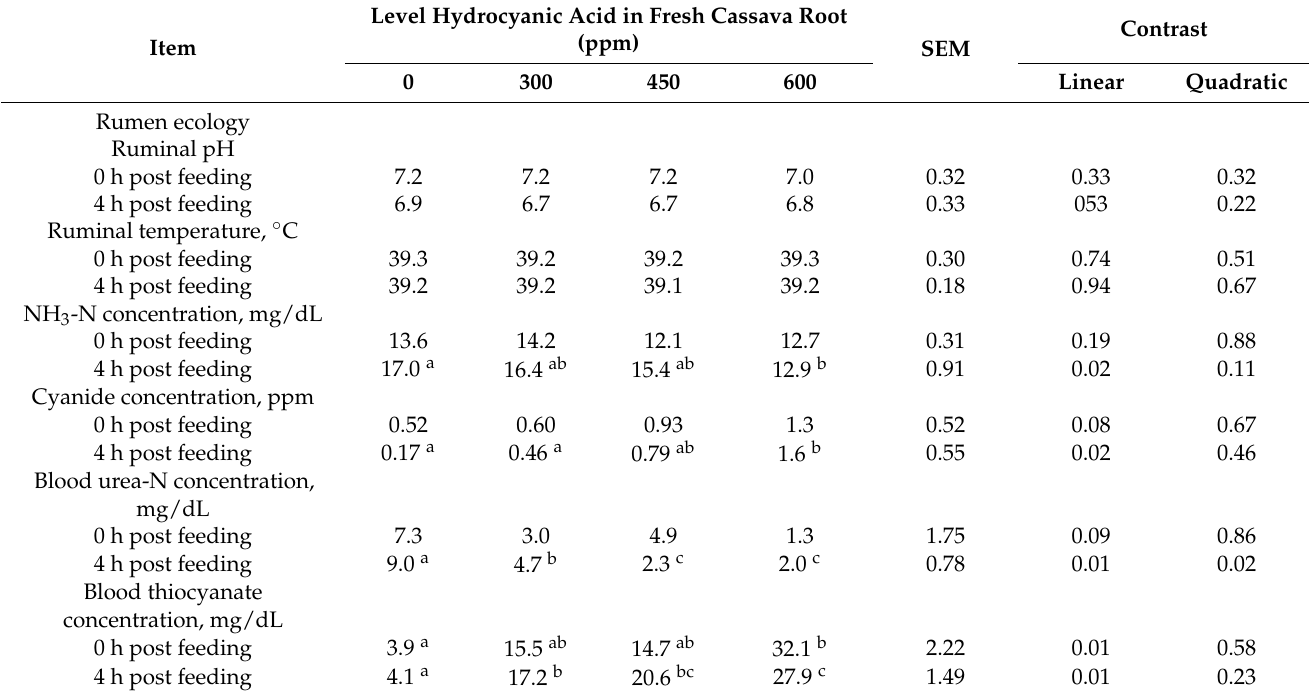
Table 3. Ruminal fermentation and blood metabolites of cattle fed fresh cassava